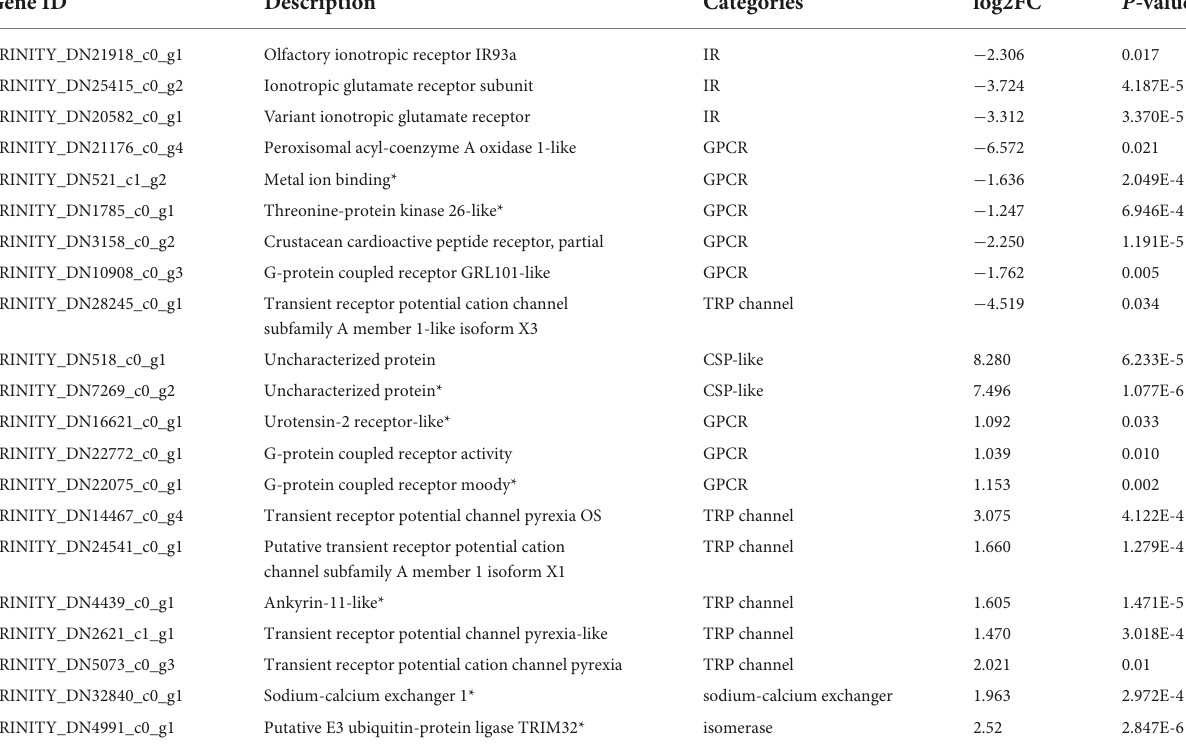
TABLE 2 Chemosensory or –like regulation-related differentially expressed unigenes